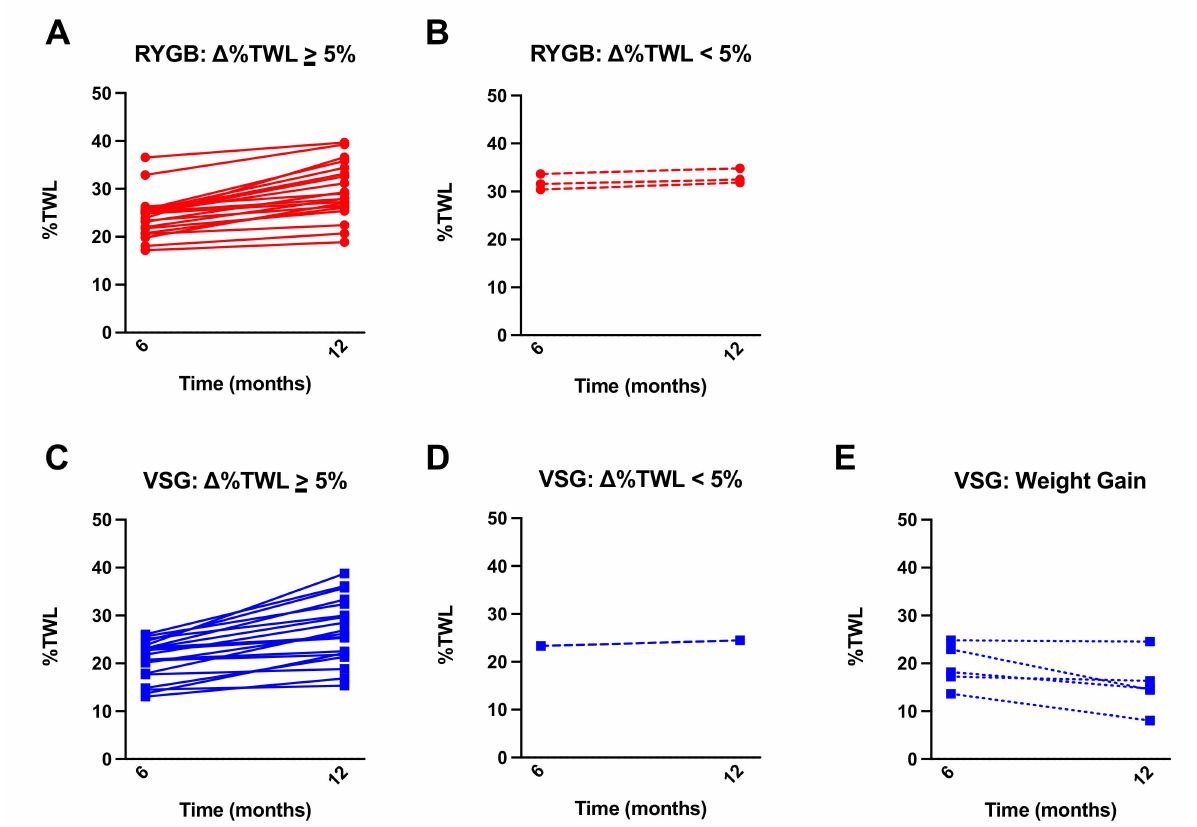
Figure 2. Mean ± SEM %TWL at six months and one year following surgery in patients who received ( A ) RYGB (red circles, solid lines) and showed equal to or greater than a 5% change in %TWL from six months to one year, ( B ) RYGB (red circles, dashed line) and showed less than a 5% change in %TWL from six months to one year, ( C ) VSG (blue squares, solid lines) and showed equal to or greater than a 5% change in %TWL from six months to one year, ( D ) VSG (blue squares, dashed lines) and showed less than a 5% change in %TWL from six months to one year, and ( E ) VSG (blue squares, dotted lines) and gained weight at 12 months relative to six